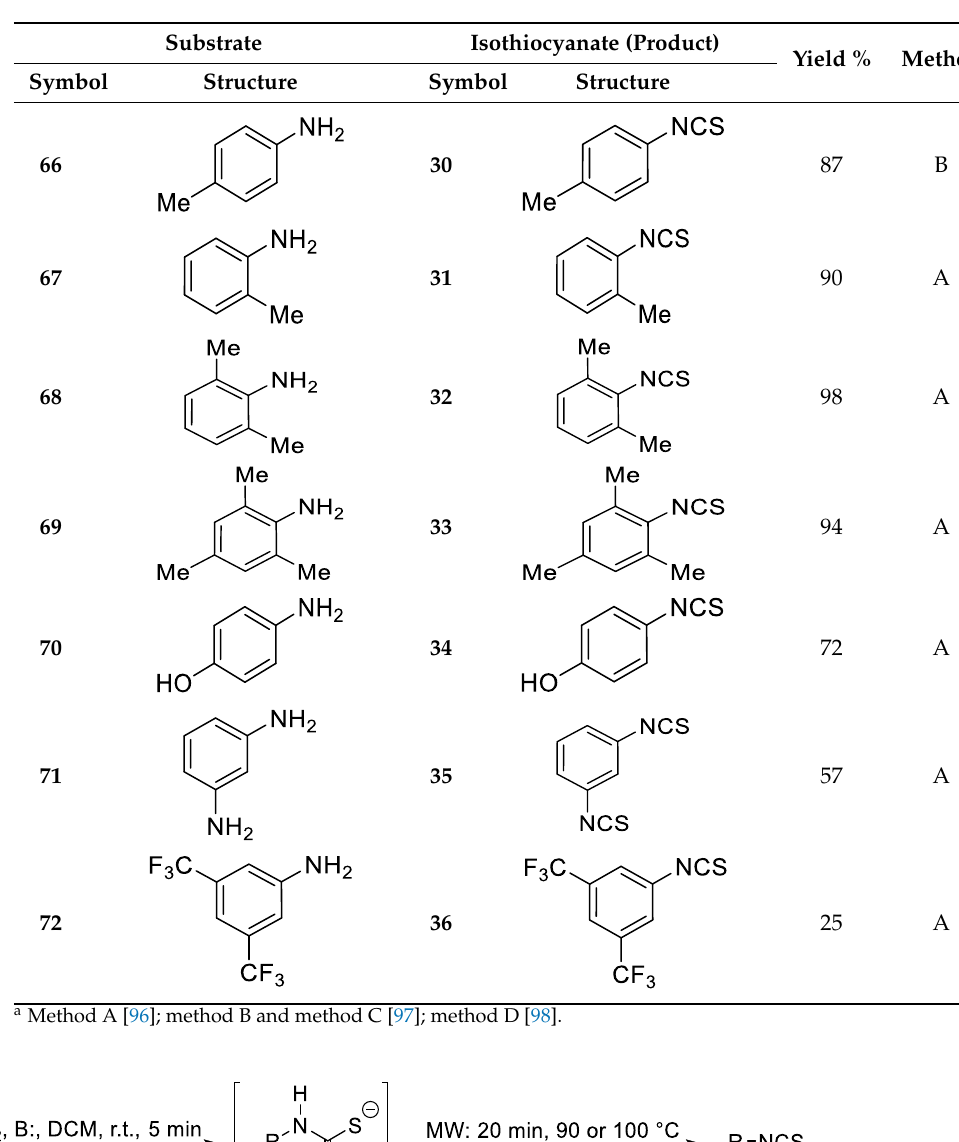
Int. J. Mol. Sci. 2022 , 23 , x FOR PEER REVIEW